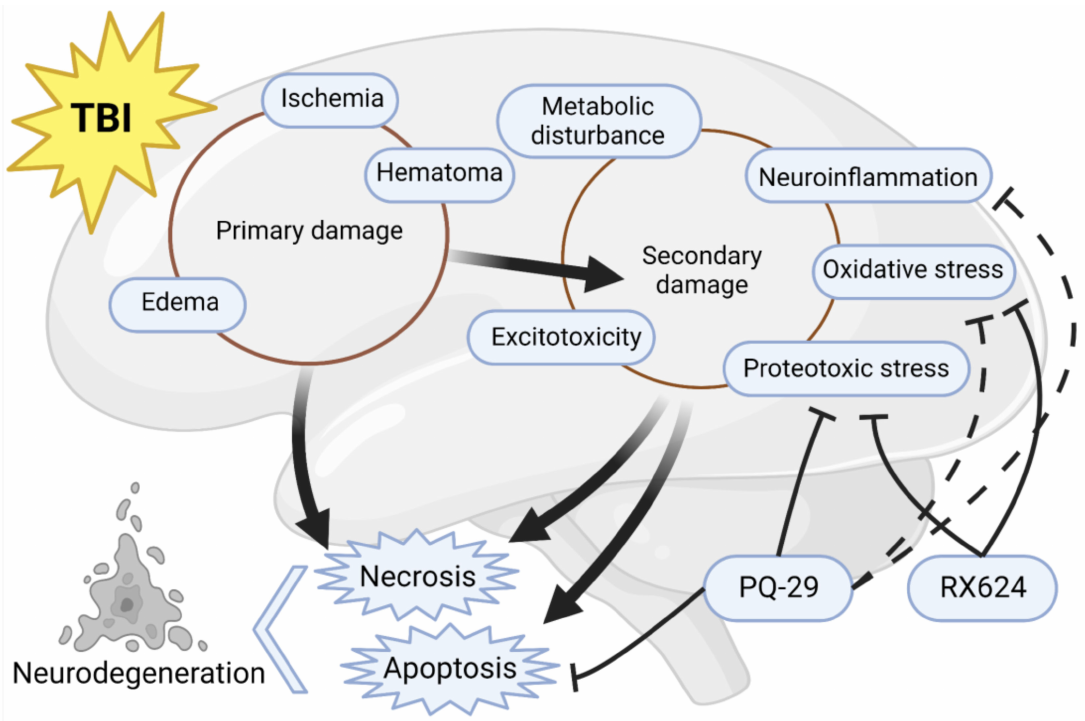
Figure 1. Influence of drugs RX624 and PQ-29 on pathological mechanisms developing after TBI. Continuous lines show the previously proven effect of PQ-29 and RX624; dotted lines show the probable (unexplored) effect of PQ-29. Created with